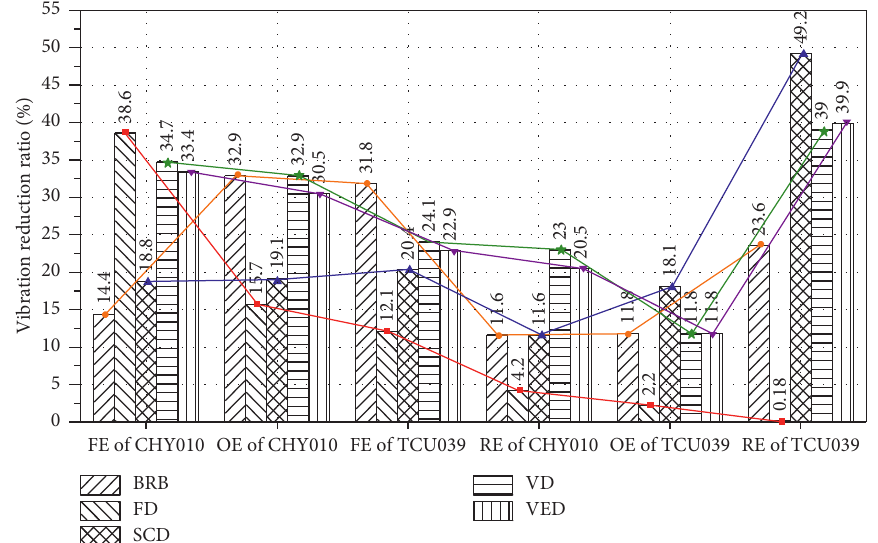
Figure 11: Curves for the vibration reduction ratios of building-damper systems with five types of dampers.